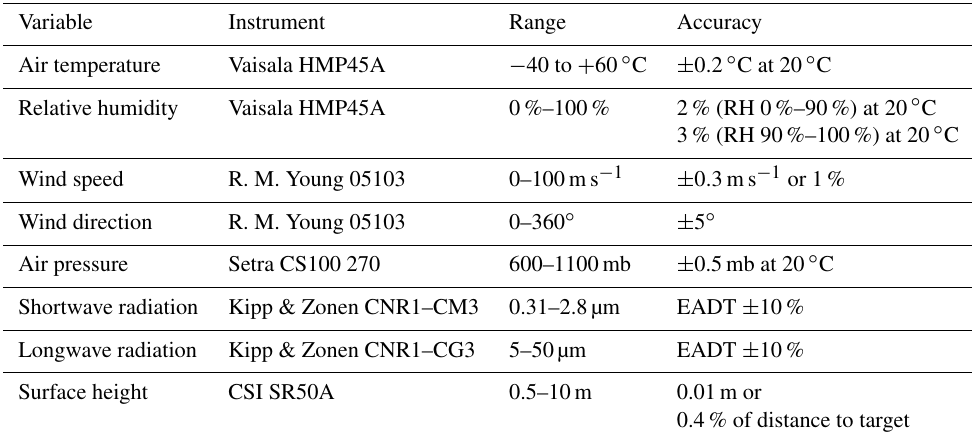
Table A1. Specifications of sensors installed on the Joyce Glacier AWS. Accuracy of the radiation observations is expressed with the estimated accuracy of daily totals